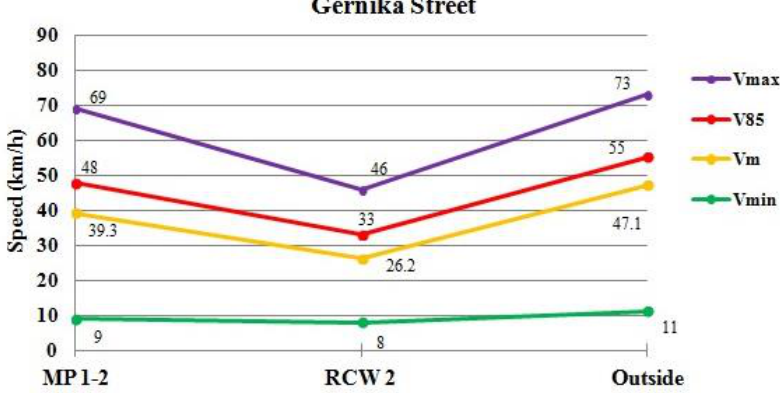
Figure 9. Speed values in the measurement points in Gernika Street, in Basauri (Spain).